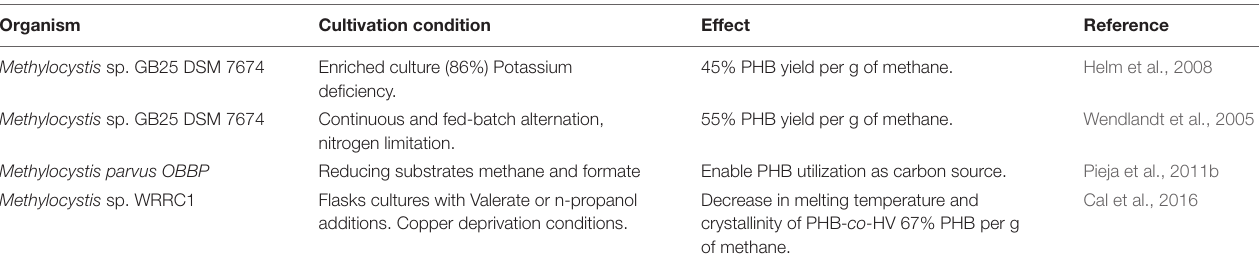
TABLE 3 | Summary of selected laboratory enrichments and the conditions involved for the production of PHA in methanotrophic bacteria. Organism Cultivation